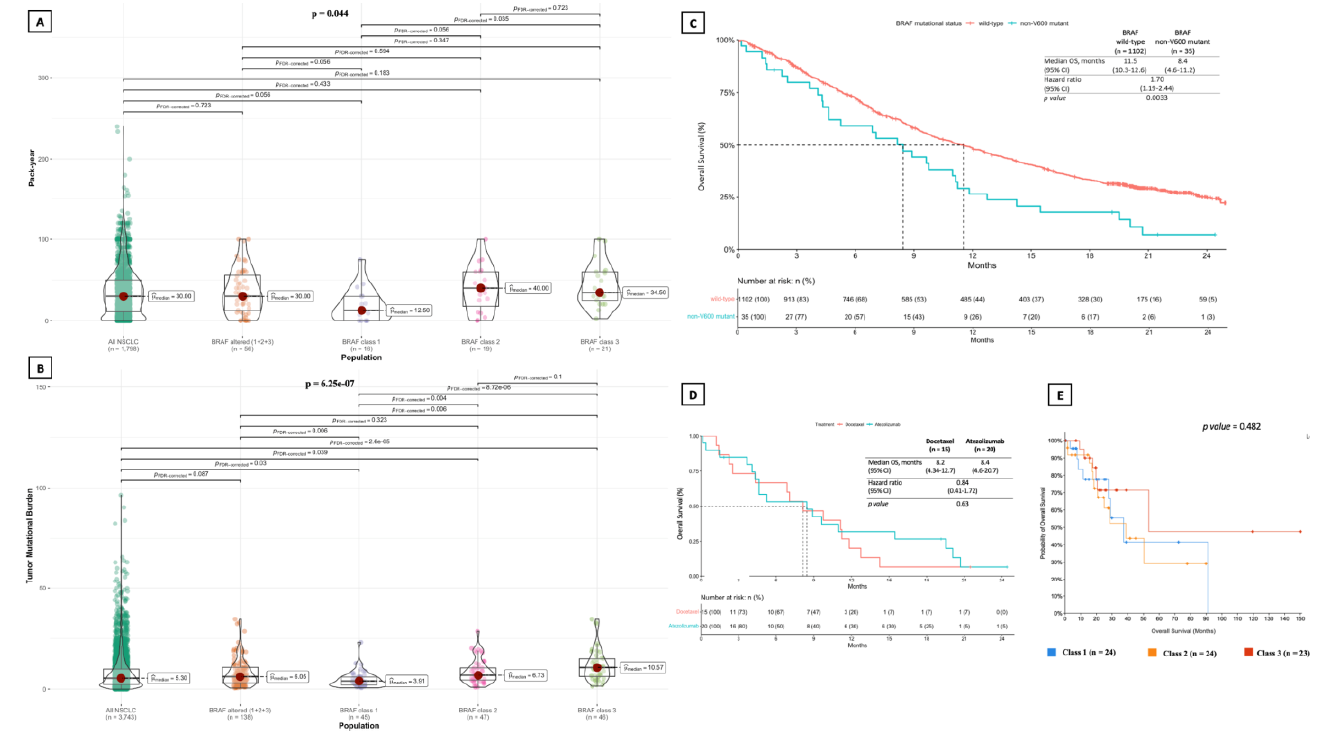
Figure 2. Comparison of smoking habit measured in pack-year among the three BRAF functional classes of alterations, showing a significantly greater pack-year value in patients harboring class 2 and class 3 BRAF alterations as compared to those with class 1 alterations ( A ). Consistently, tumor mutational burden (TMB) was significantly higher in patients harboring class 2 and class 3 BRAF alterations as compared to those with class 1 alterations ( B ). No statistically significant difference in terms of median TMB was found between patients harboring BRAF alterations of known functional class and all patients with NSCLC in the cBioPortal cohort. Kaplan–Meier of overall survival of patients with distinct BRAF alteration classes shows no statistically significant differences between classes in the POPLAR/OAK cohort ( C ), regardless of the treatment type (docetaxel or atezolizumab) ( D ). No statistically significant differences were found in terms of overall survival in patients harboring different classes of BRAF alterations in the cBioPortal cohort ( E ). TMB: tumor